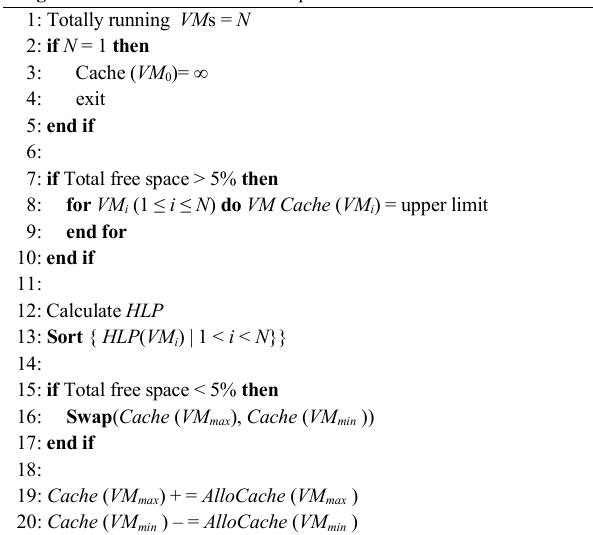
Algorithm 2 Allocation of Cache